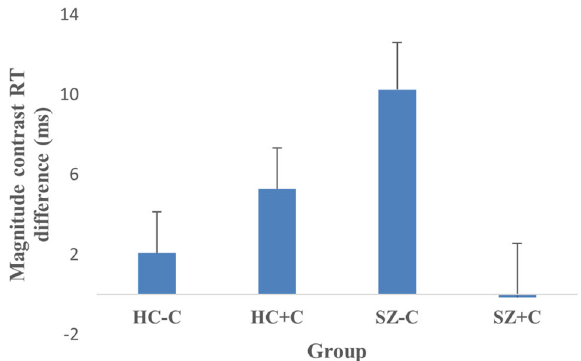
milliseconds, HC − C non-cannabis user healthy controls, HC + C cannabis-user healthy controls, SZ − C non-cannabis user schizo- phrenia patients, SZ + C cannabis-user schizophrenia patients. Error bars indicate standard errors of the mean